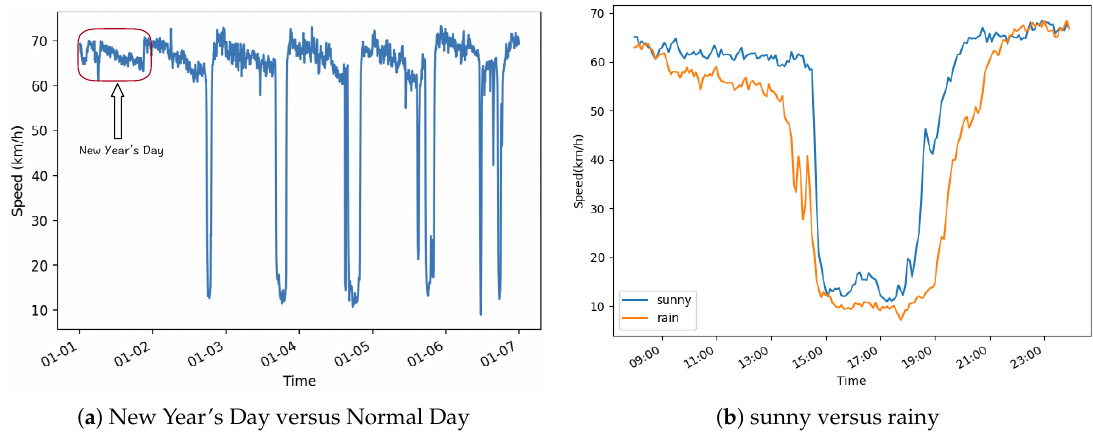
Figure 3. Effects of holidays and weather in San Francisco Bay